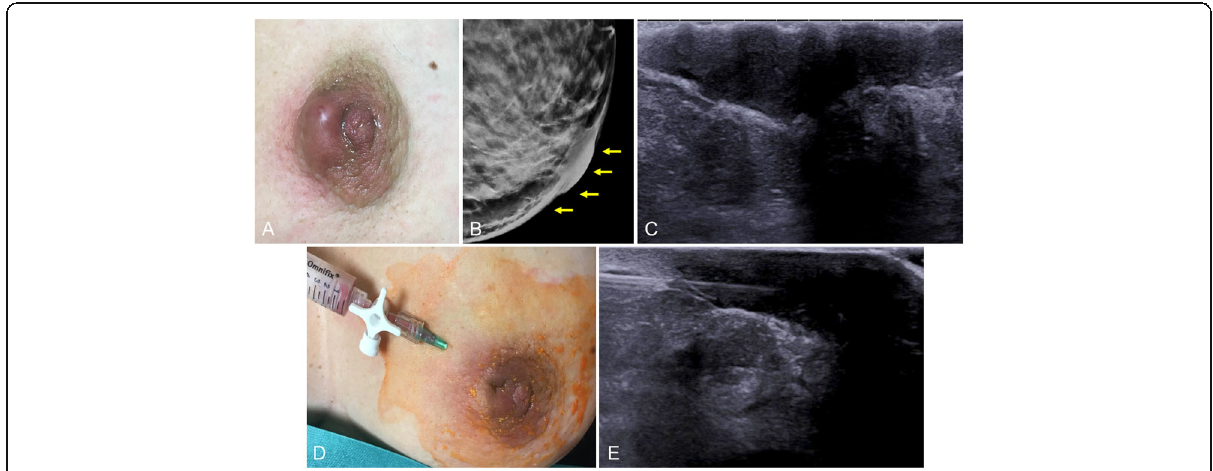
Fig. 22 Subareolar abscess. Photograph of a 42-year-old woman with a painful erythematous palpable areolar mass in her left breast with mild involvement of the adjacent skin ( a ). Synthesized 2D mammogram shows marked skin thickening of the nipple-areolar complex without other underlying findings ( b ). Ultrasound shows a heterogeneous hypoechogenic intradermal collection compatible with an abscess ( c ). Fine-needle aspiration was able to drain the collection completely (purulent material), and the patient was prescribed antibiotics and follow-up ( d , e